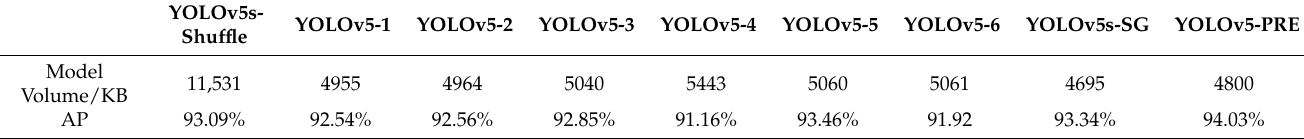
Table 3. Performance of ablation experiment